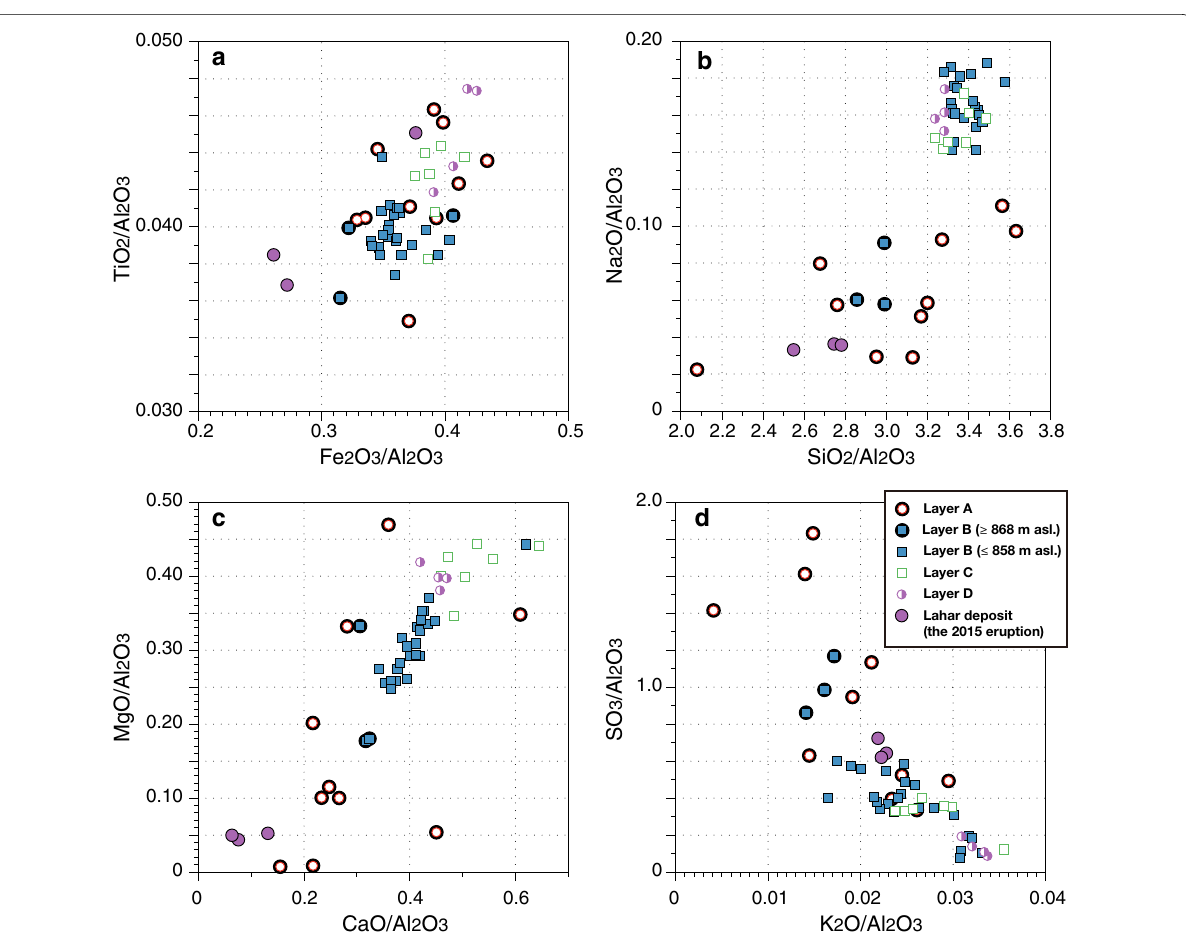
Fig. 3 Variation in rock chemistry of SPW52. To depict the modification of the chemical composition due to the hydrothermal alteration, all oxide contents are standardized using that of Al 2 O 3 , which is considered the most immobile element during hydrothermal alteration. The samples from deep depths ( 858 m asl) form a cluster, whereas those from shallower depths scatter, which indicates higher alteration at shallower depths. The ≤ deeper and shallower depths indicate no significant difference for the Fe and Ti content ( a ); however, lower Na, Si ( b ), Ca, Mg ( c ), and K ( d ) indicate leaching of those elements at shallow depths. The higher sulfur content in the shallow depths indicates that sulfuric acid is a leaching agent ( d